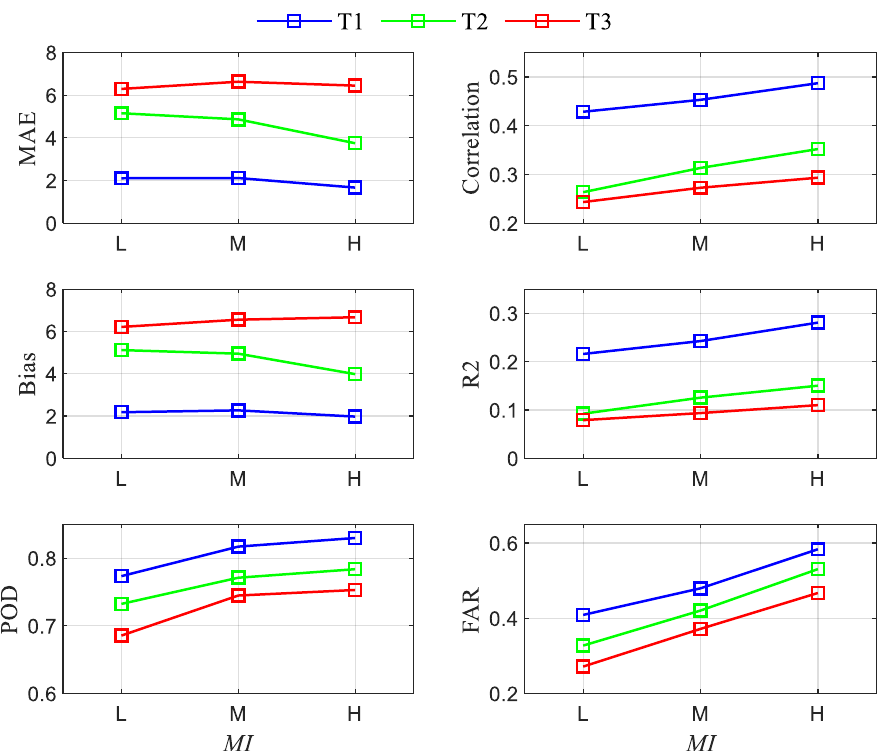
Figure 10. Comparison of rainfall nowcasting skills shown in Figure 6 under different lead times and rainfall spatial CVs.